Question: What form of chart is displayed?
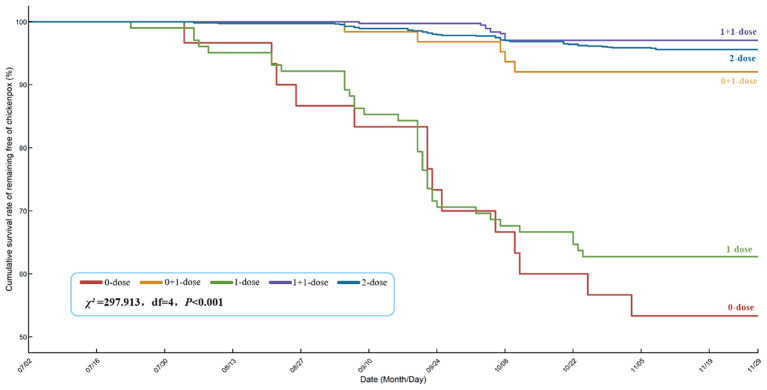
Answer: survival